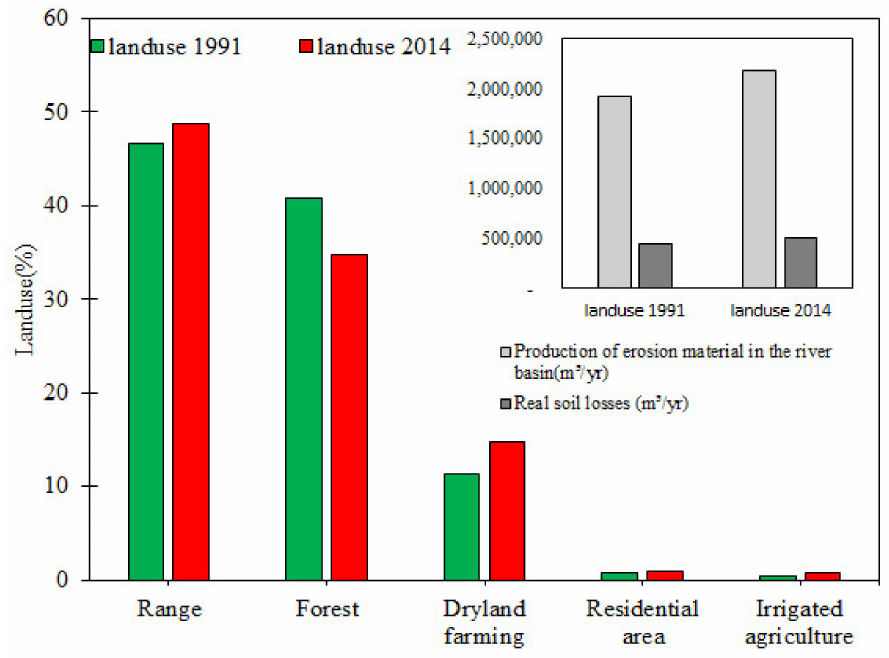
Figure 6. Land use changes (1991–2014), production of erosion material and real soil